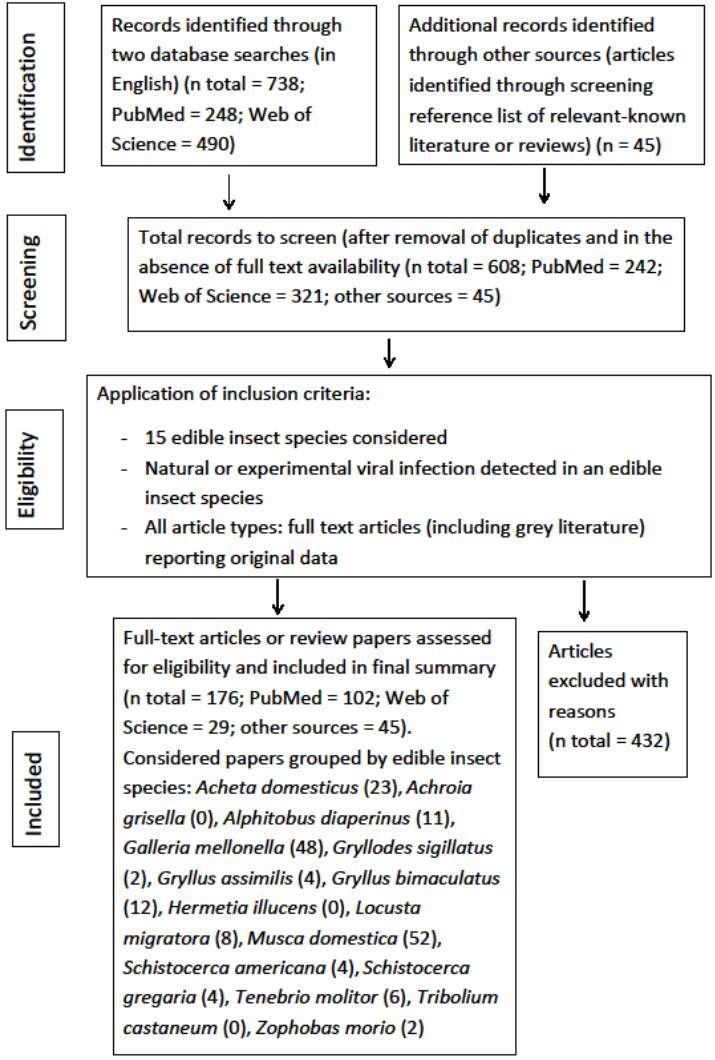
Figure 1. PRISMA flowchart diagram of the selection of eligible studies (literature research up to February 2021).